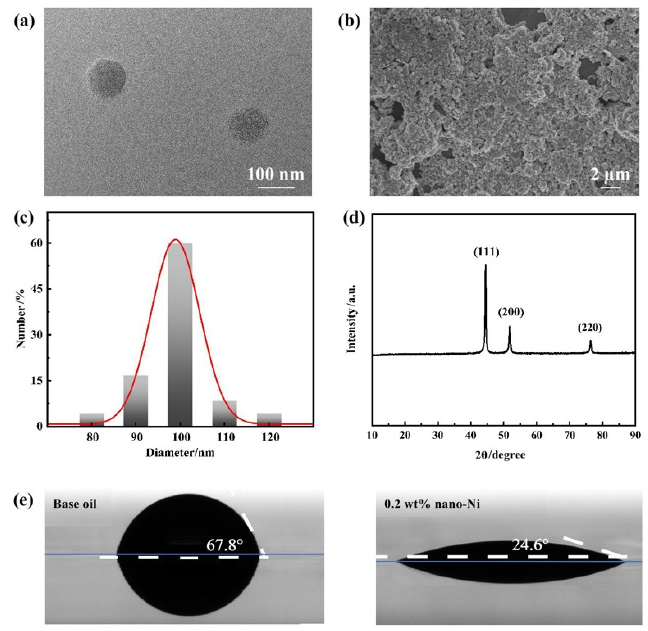
Figure 3. Characterization results of nanometer Ni: ( a ) TEM image; ( b ) SEM image; ( c ) particle size distribution; ( d ) XRD pattern; ( e ) contact angle diagram.